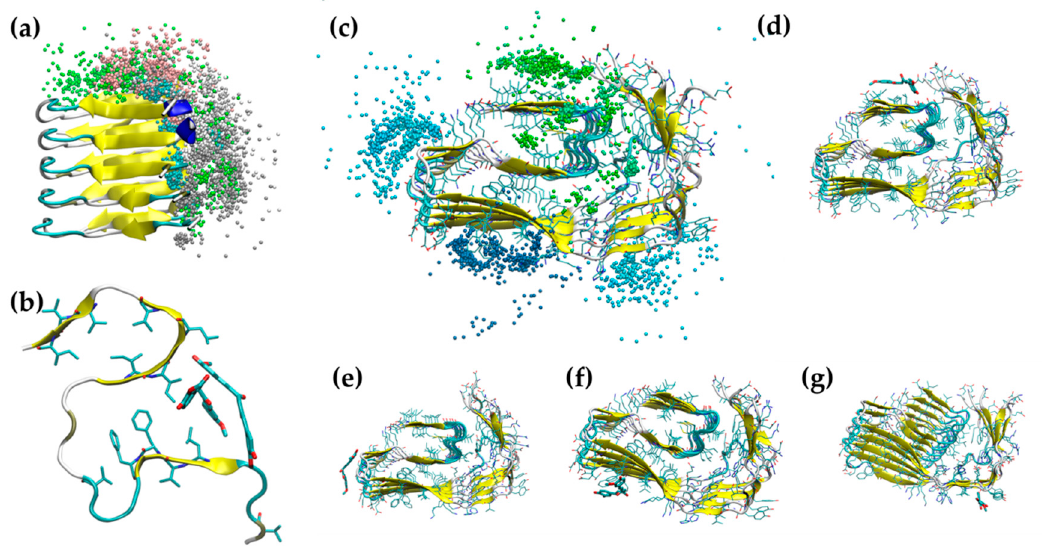
Figure 7. Curcumin binding to ( a,b ) 2MXU and ( c – g ) 5OQV A β fibrils. Superposition of curcumin coordinates (center of mass) during the 2MXU MD simulations ( a ) and a snapshot of the main binding area ( b ). Superposition of curcumin coordinates during the 5OQV MD simulation ( c ) and snapshots of the main binding area ( d – g ).